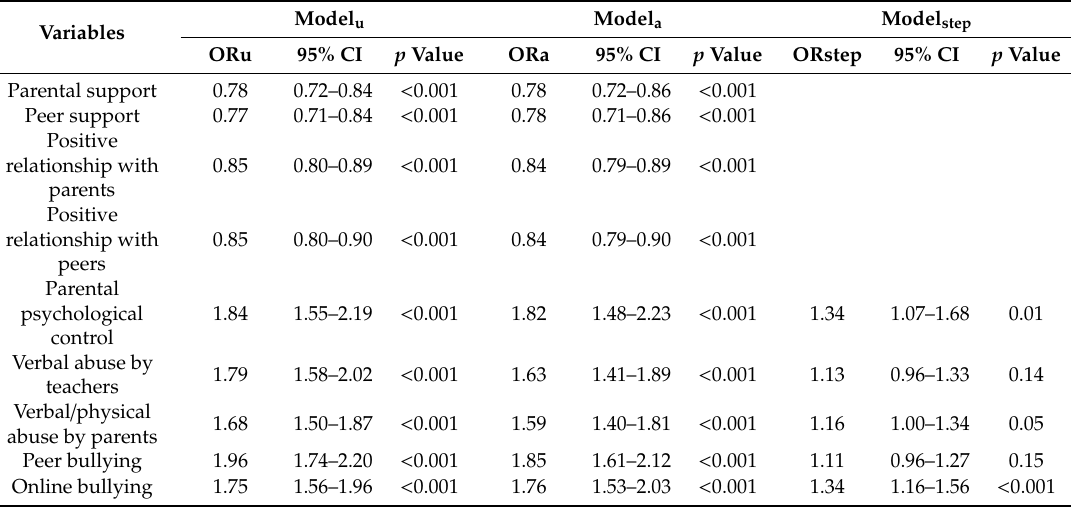
Table 3. Logistic regression analyses of interpersonal variables of